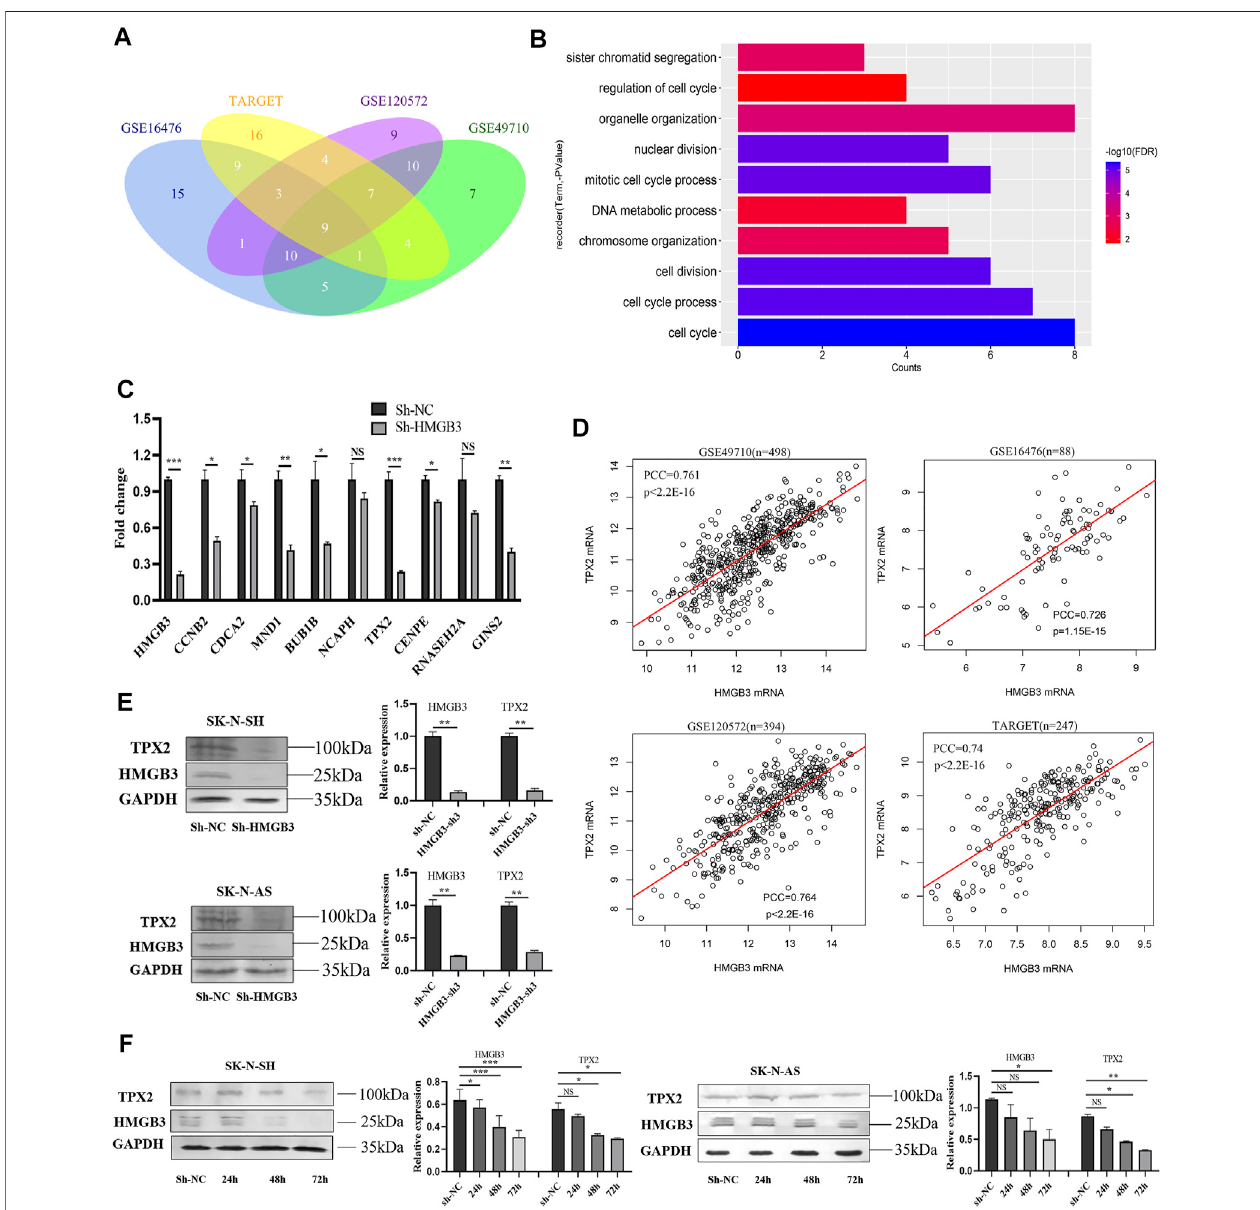
FIGURE 4 | HMGB3 could inhibit cell survival via TPX2 in NB cells. (A) Nine genes signi fi cantly co-expressed with HMGB3 in four datasets of NB. (B) Functional enrichment analysis of nine genes. (C) The mRNA expression of nine genes was detected by qRT-PCR in SK-N-SH cells after HMGB3 knockdown. (D) Pearson correlationofHMGB3and TPX2infour NBdatasets. (E) Proteinexpression ofTPX2 andHMGB3 wasdetected bywestern blottingafter HMGB3knockdown. (F) TPX2 reduction was time-dependent with HMGB3 knockdown in SK-N-SH and SK-N-AS cells. * p < 0.05, ** p < 0.01, and *** p < 0.001.